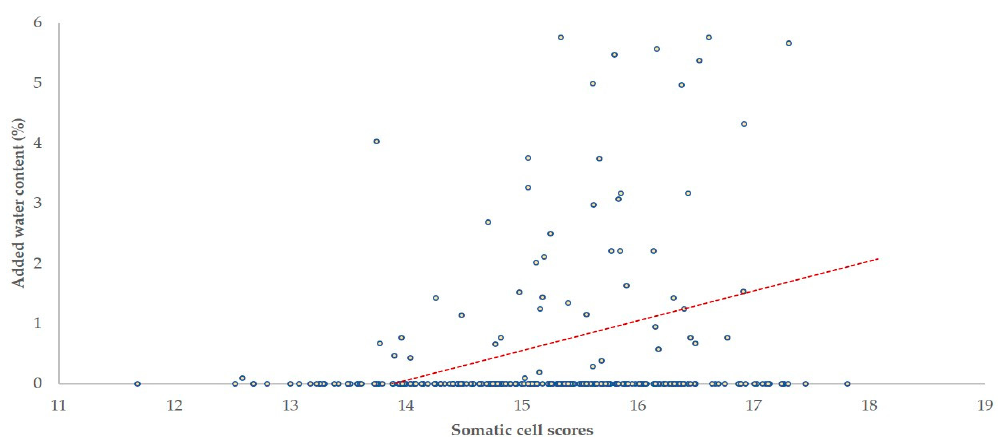
Figure 9. Somatic cell scores [log 2 (SCC/100) + 3] and added water content in the bulk-tank milk of 325 sheep flocks in Greece (dashed line: tendency line).